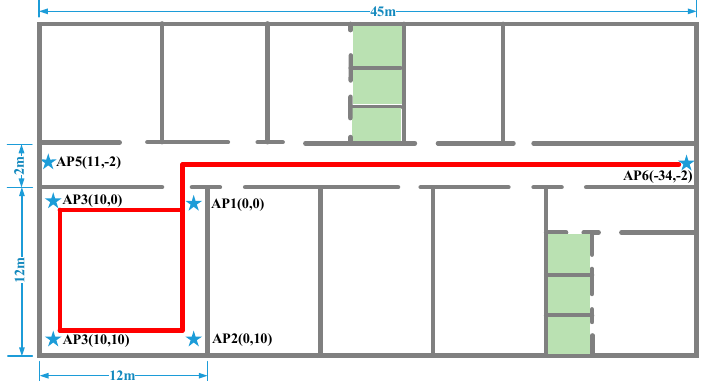
Figure 13. Experimental site contains office and corridor.